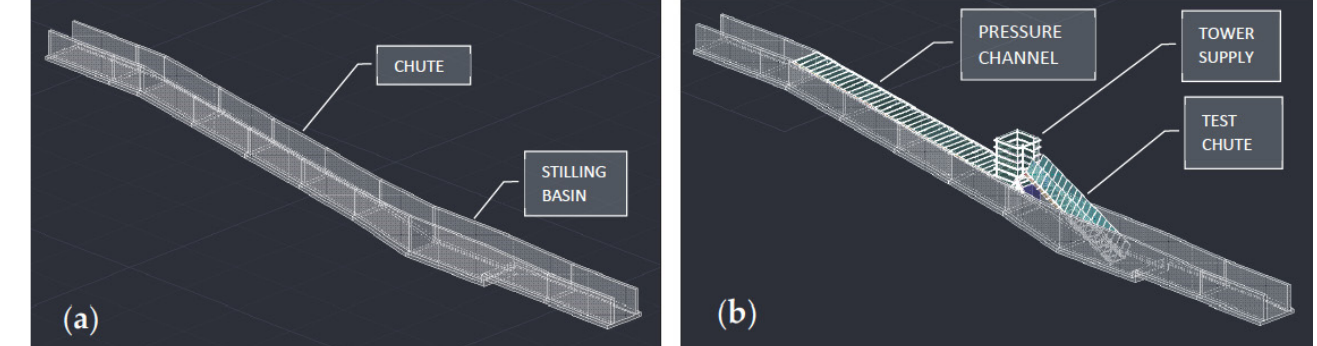
Figure 3. 3D view of the auxiliary channel ( a ) Initial situation ( b ) Situation after the installation of HEFLR.